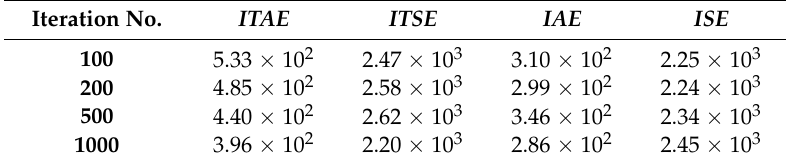
Table 2. Comparison of different errors, ITAE , ITSE , IAE , ISE as performance index (fitness function). Iteration No. ITAE ITSE